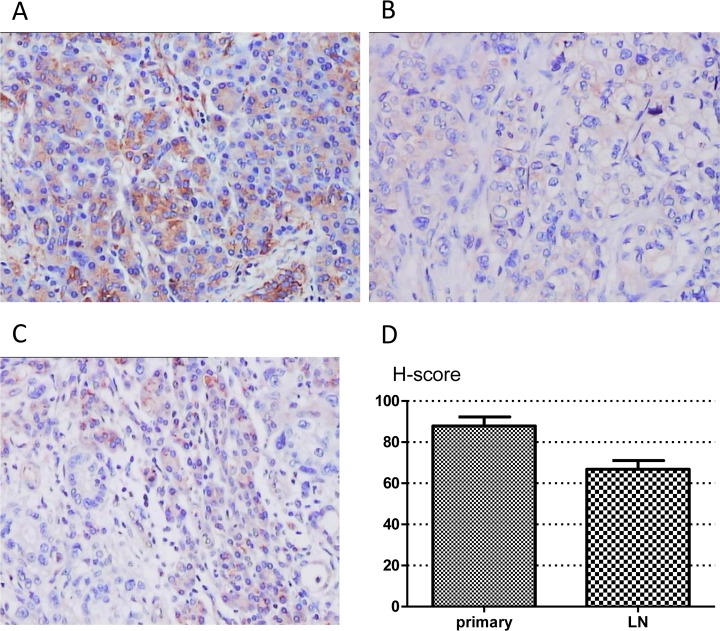
TUSC3 is decreased in pancreatic cancer samples.(A) TUSC3 expression in non-neoplastic pancreatic tissues (acinar, duct and islets). (B) TUSC3 expression in pancreatic cancer cells. (C) Low TUSC3 expression in pancreatic cancer cells compared to islets. (D) Comparison of TUSC3 staining in primary PC and LN metastasis(paired t-test, p<0.001, n = 58). Original magnification×200.